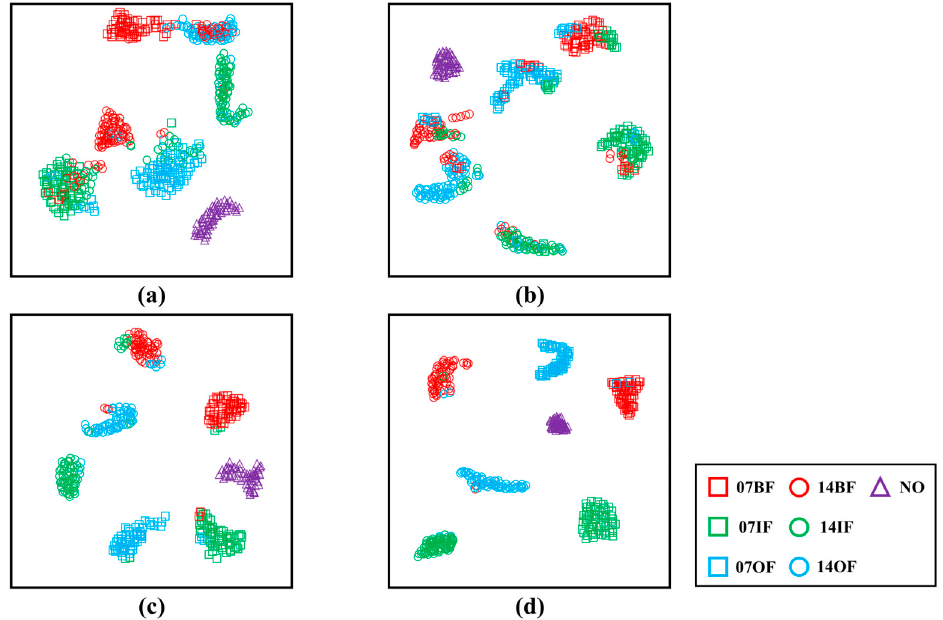
Figure 15. Visualizations of the learned feature representations in the fully connected layer in the feature extractor: ( a ) DAN; ( b ) Deep CORAL; ( c ) DANN; ( d ) Proposed.